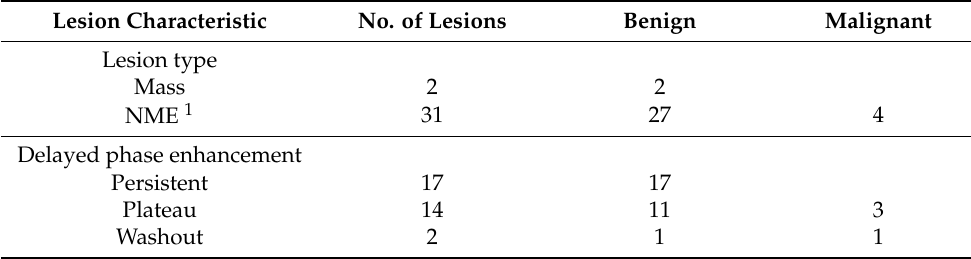
Table 1. The MRI characteristics of 33 additional lesions detected with MRI only. Lesion Characteristic No. of Lesions Benign Malignant Lesion type Mass 2 2 NME 1 31 27 4 Delayed phase enhancement Persistent 17 17 Plateau 14 11 3 Washout 2 1